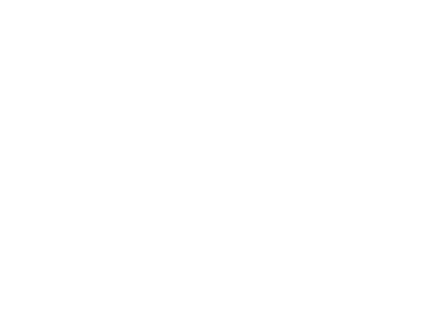
Table 1. Transcriptome assembly results for all